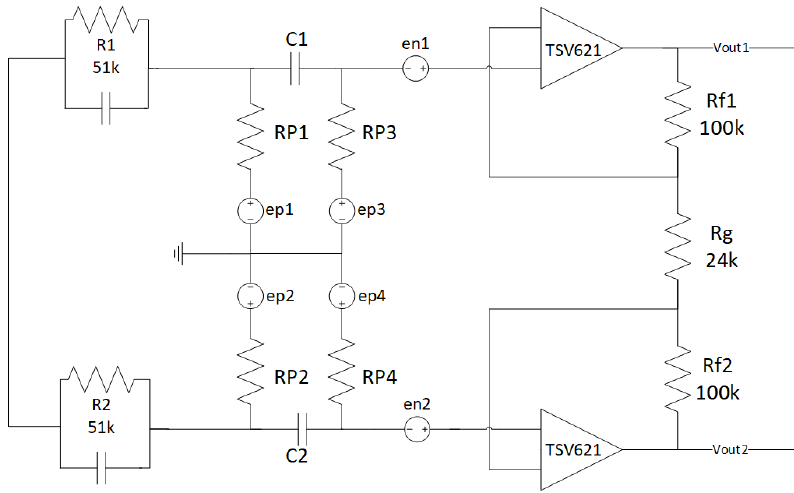
Figure 7. Noise analysis of the proposed pre-amp stage with Zep = 0.